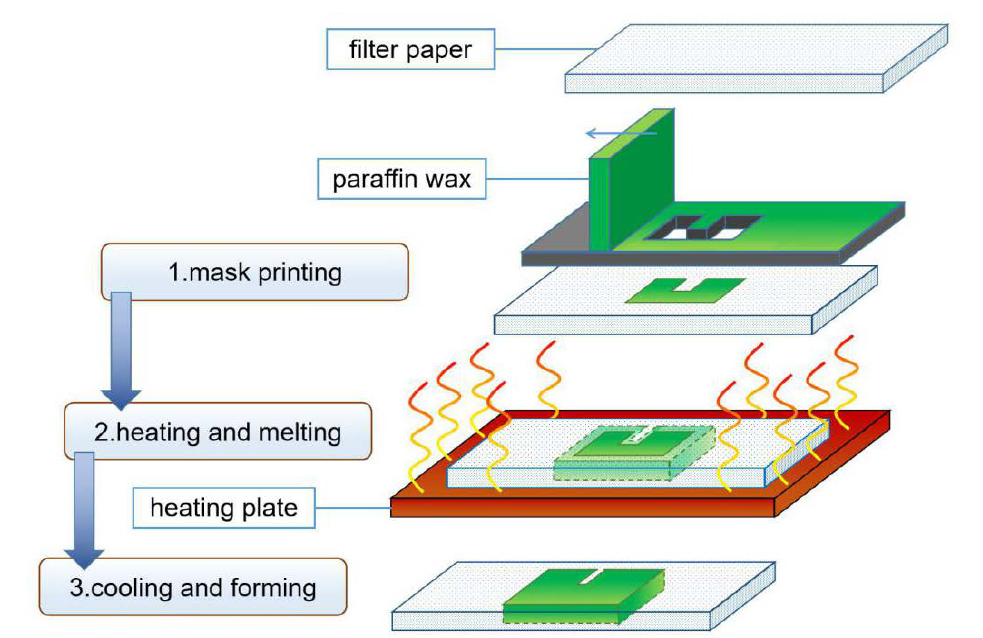
Figure 3. Schematic diagram of paper chip prepared by screen-printing